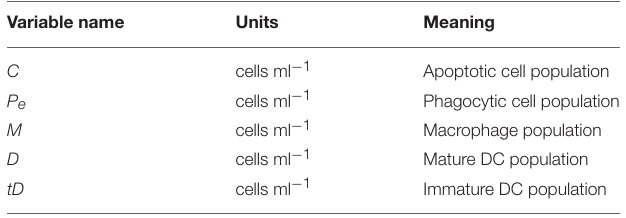
TABLE 1 | State variables describing the cell populations relevant to the ODE model fit to data from Albert et al. (1998), as well as their meanings. Variable